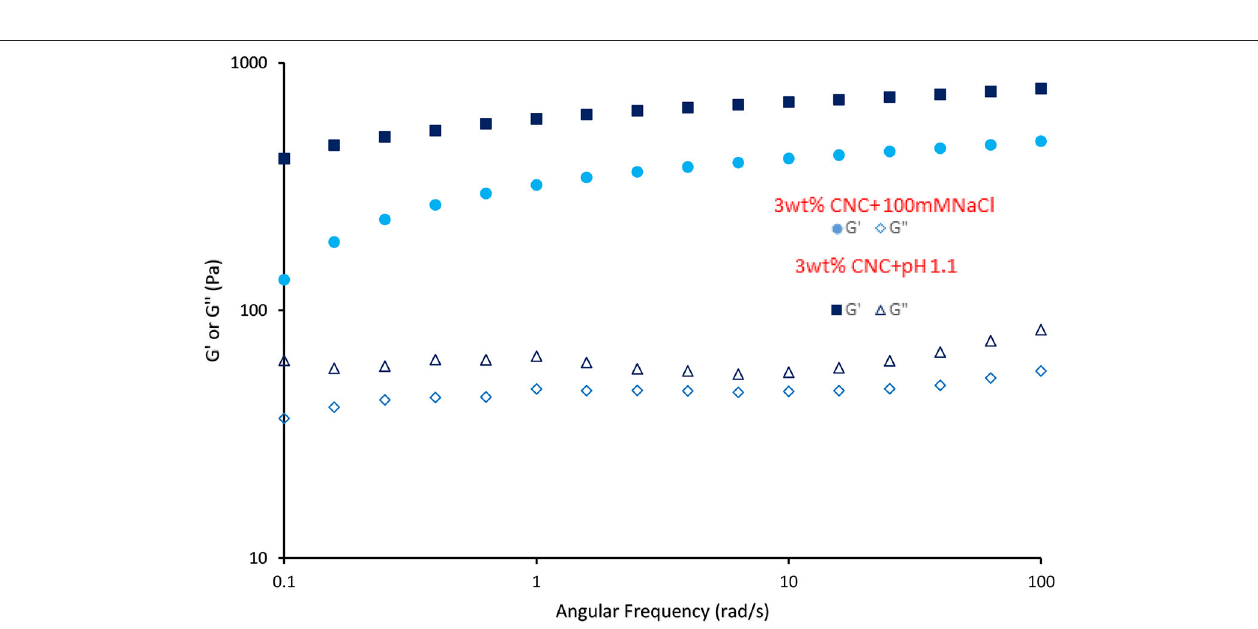
FIGURE 13 | Dynamic frequency sweep of gel like CNC emulsion (3 wt% CNC and 100mM NaCl, 3 wt% CNC and pH 1.1) at 25 ◦ C and 0.1% strain. Filled symbol indicate elastic moduli (G’) and unfilled symbol indicate loss moduli (G”).